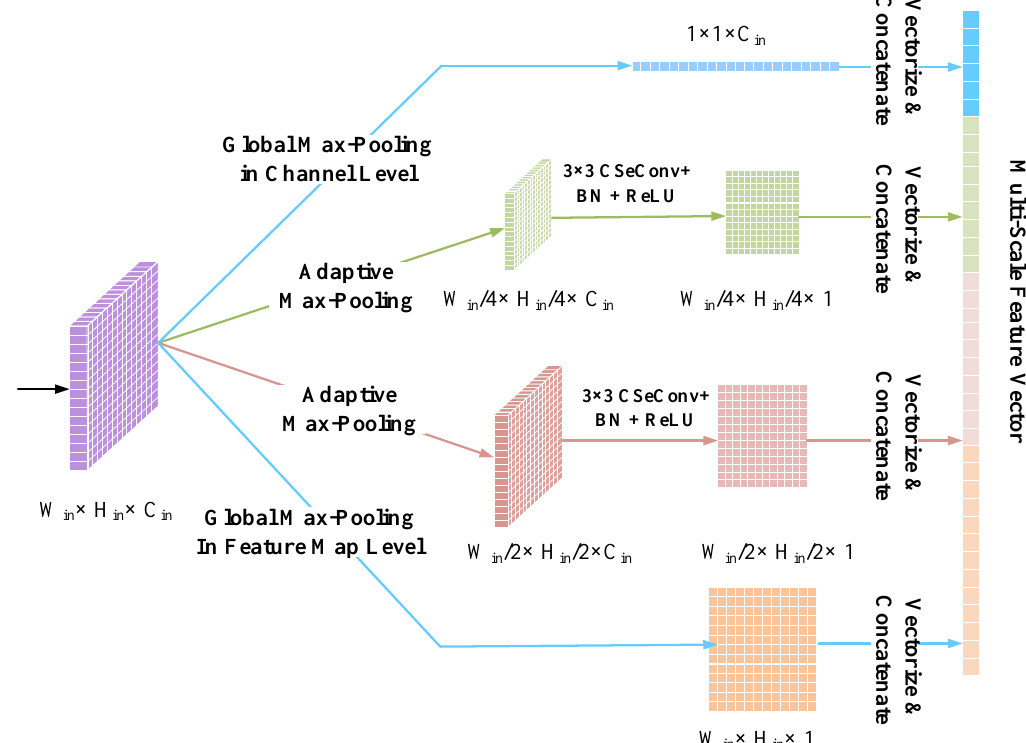
Figure 7. The architecture of the proposed pyramid pooling module (PPM) for multi-scale representation learning at each modality level. Given an input feature map with the size of 𝑊 𝑖𝑛 × 𝐻 𝑖𝑛 × 𝐶 𝑖𝑛 , the output feature maps of the four sub-branches of the PPM are with the size of 1 × 1 × 𝐶 𝑖𝑛 , 𝑊 𝑖𝑛 × 𝐻 𝑖𝑛 × 𝐶 𝑖𝑛 , 𝑊 𝑖𝑛 × 𝐻 𝑖𝑛 × 𝐶 𝑖𝑛 , and 𝑊 𝑖𝑛 × 𝐻 𝑖𝑛 × 1 . 4 4 2 2